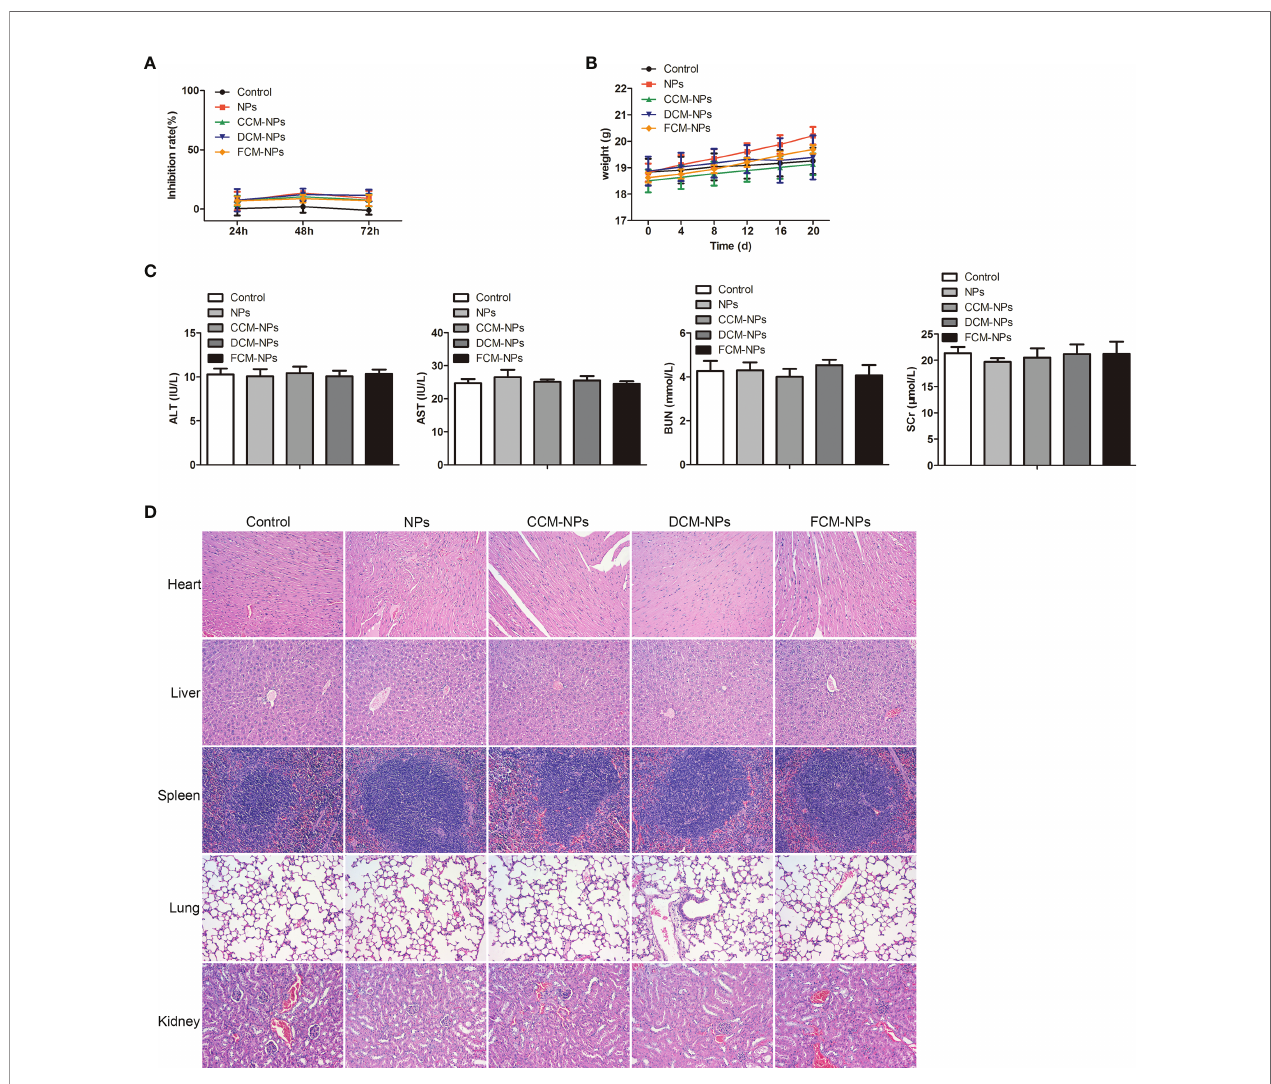
FIGURE 8 | Biosafety evaluation of FCM-NPs. (A) The cytotoxicity of FCM-NPs to hepatocyte HL7702 and renal tubular epithelial cell HK-2 was assessed by MTT assay. (B) Body weight changes of mice with subcutaneous transplanted tumor and vaccines treatment. (C) Liver and kidney function indexes. (D) HE staining images of major organs of subcutaneous transplanted tumor model mice after vaccine